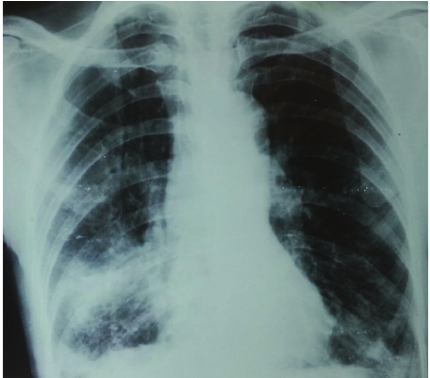
Figure 1: Chest X-ray with minimally advanced lesion.